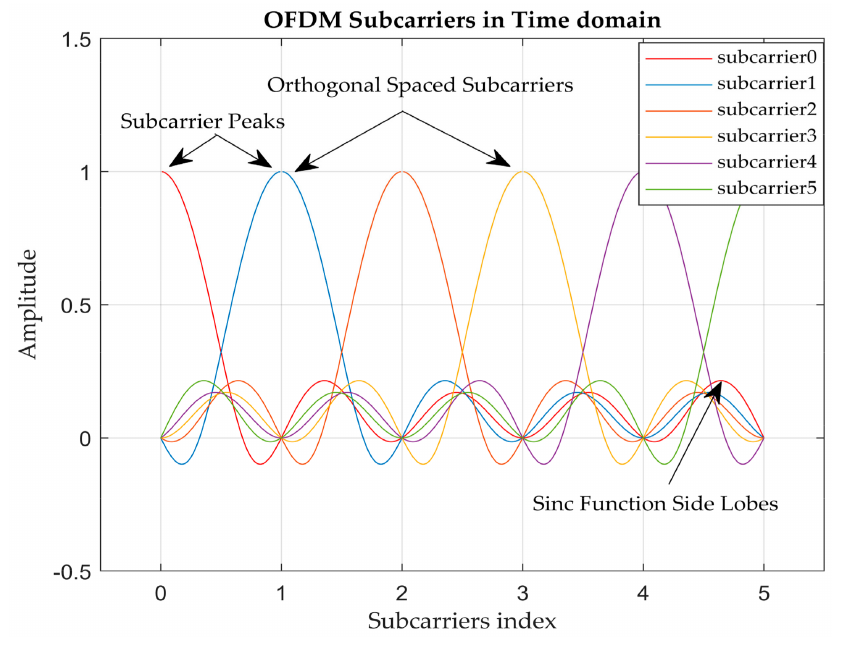
Figure 2. Orthogonality concept of subcarriers in OFDM.